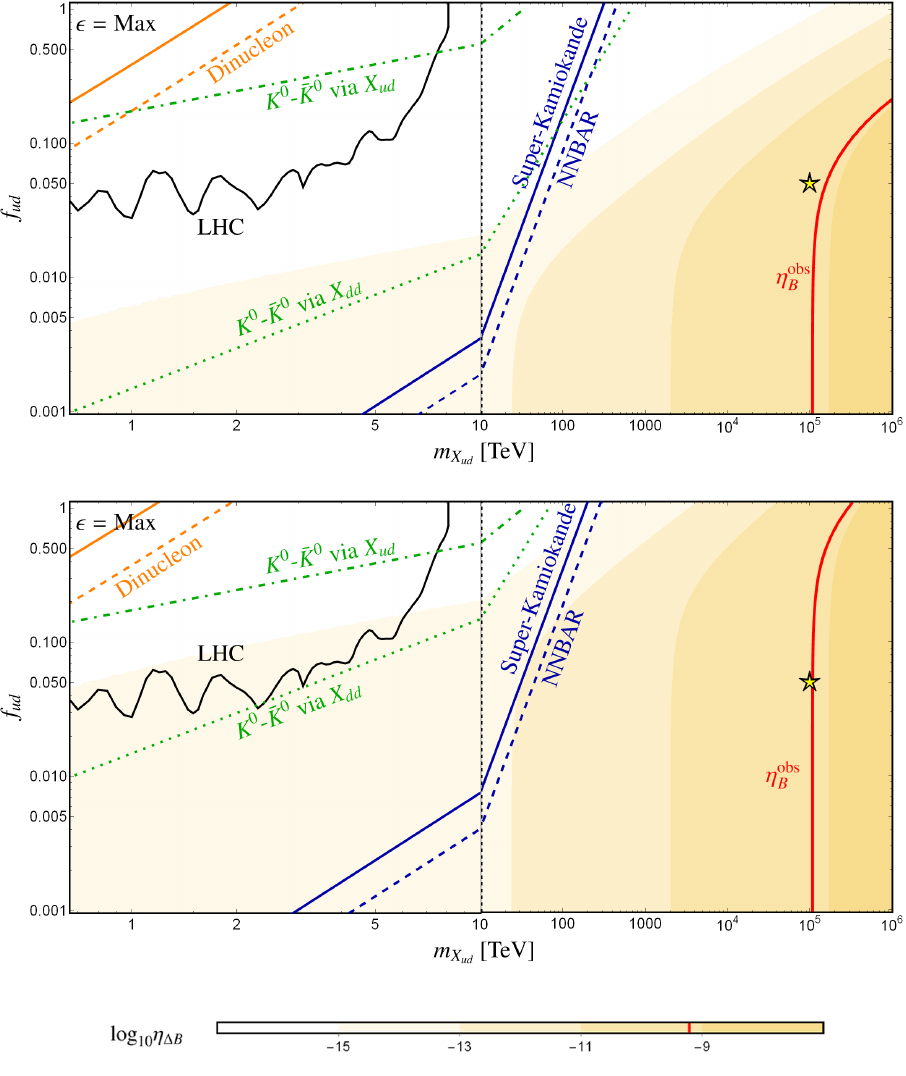
Figure 20 . Low-scale scenario. Yellow shading indicates the final baryon asymmetry η ∆ B at the time of electroweak symmetry breaking in the m – f plane. The diquark couplings are X ud ud chosen as follows: Top: f = f . Bottom: f = 10 f . In both plots, we chose λv 0 = 1 . 2 m , ud dd ud dd X dd = 3 m , and the maximal CP asymmetry (cid:15) = 2 r is used. The red line indicates the observed m X X ud dd value of the baryon asymmetry η obs , while the orange, green, black, and blue lines correspond to B experimental constraints coming from dinucleon decay, meson oscillations, the LHC, and n - ¯ n oscil- lations respectively. For the dinucleon and n - ¯ n oscillation constraints, solid lines represent current experimental bounds, while dashed lines show projected future sensitivities. For the meson oscilla- tion constraints, dotted and dot dashed lines correspond to tree-level oscillation via a X mediator, dd and box-diagram oscillation involving an X diquark, respectively (see section 4 for details). For ud √ the LHC limit CMS data with s = 13 TeV and 36 fb − 1 integrated luminosity was used